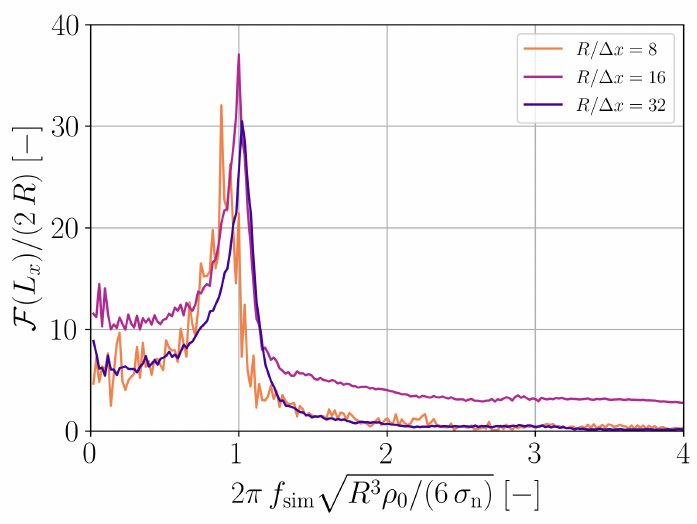
Figure 3. Fourier analysis of the droplet oscillation shown in Figure 2.